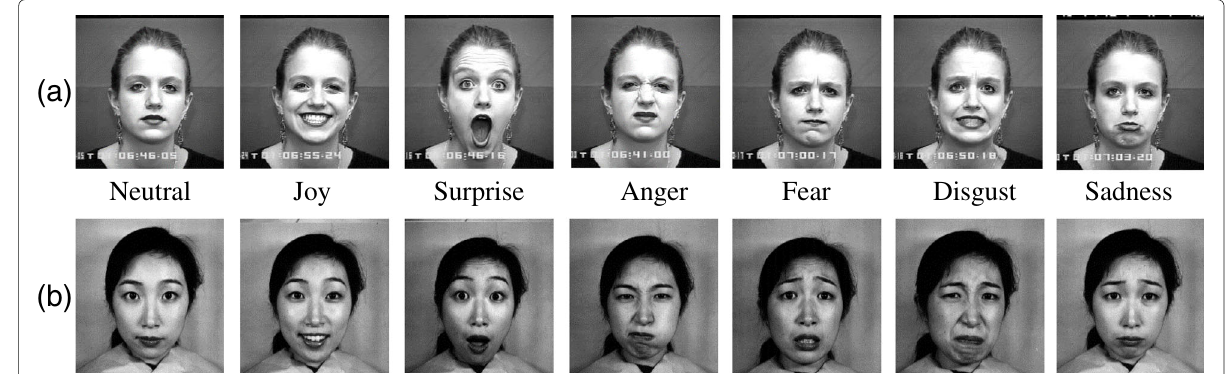
Fig. 4 Sample prototypic expressions from a CK+ dataset and b JAFFE